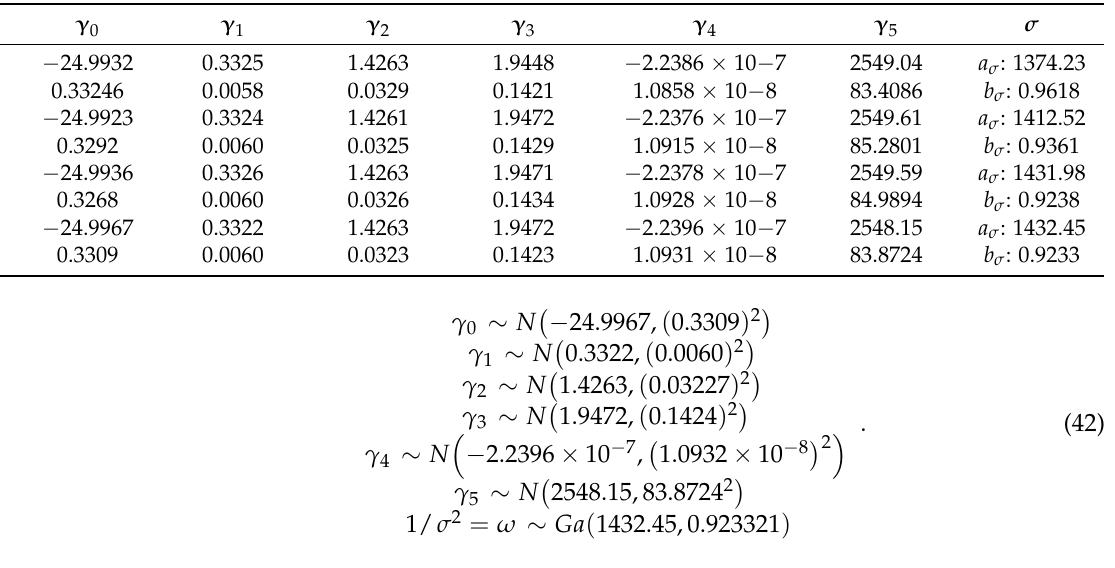
Figure 13. The update process of probability density of each model parameter with the test ( l = 1). Table 10. The posterior distribution of each model parameter at stress level l = 1.